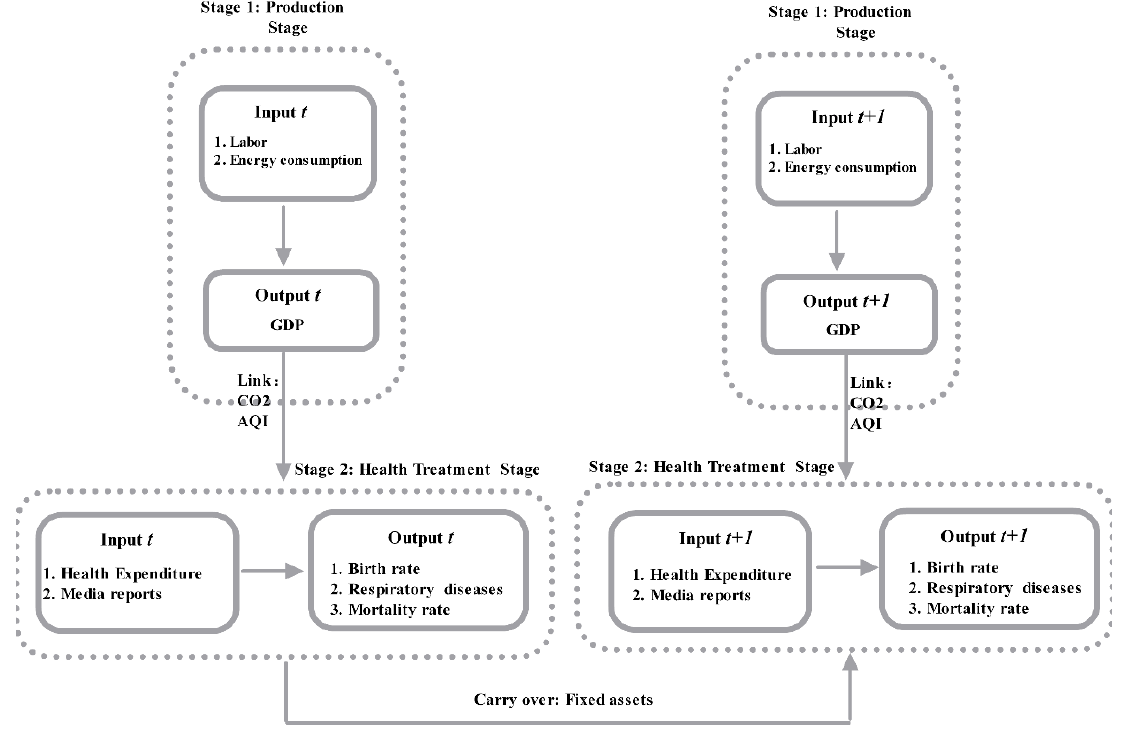
Figure 2. Undesirable Dynamic Network Model.